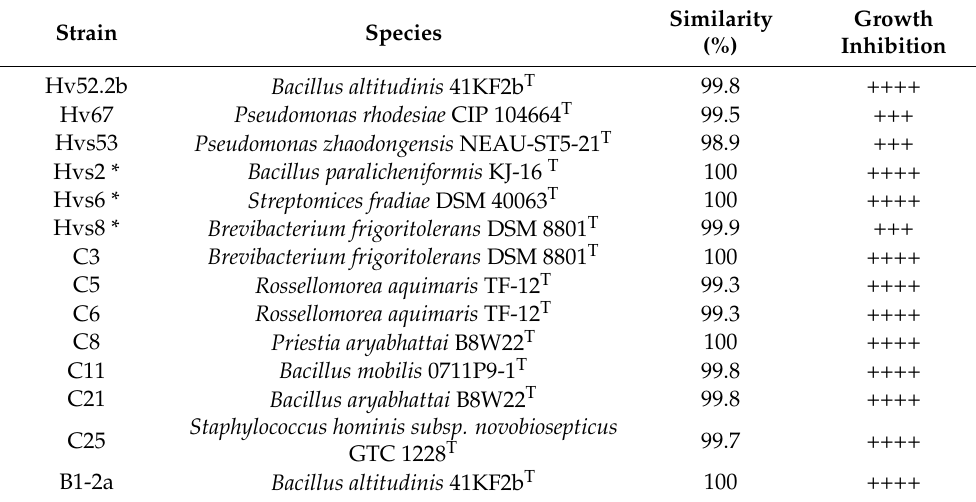
Table 1. Phylogenetic affiliation of the isolated strains and score of Macrophomina phaseolina growth inhibition on antagonistic in vitro